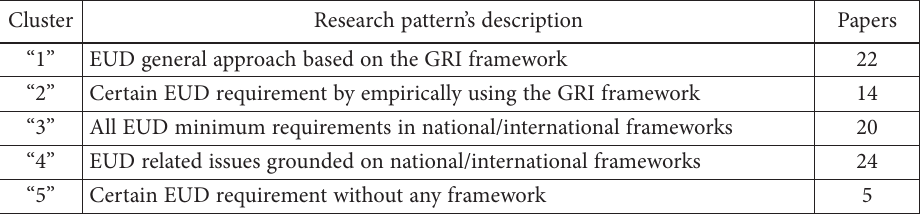
Table 7. Linkage between clusters and patterns on research design Cluster EUD Research pattern’s description Papers “1” Theoretical general approach globally